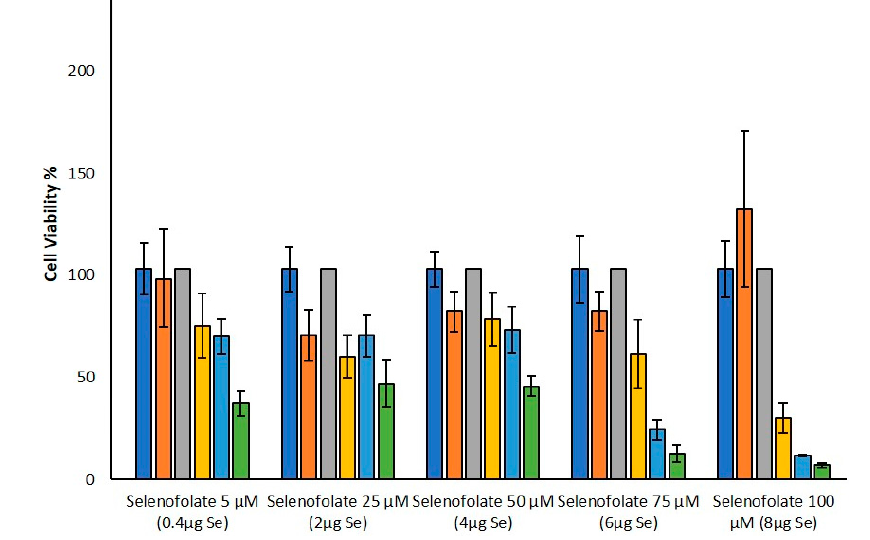
Figure 8. Analysis of metabolic activity as a function of percent cell viability during treatment of HME50-5E cells. Metabolic activity of ( a ) control and selenite, ( b ) Folic acid and ( c ) Selenofolate treated HME50-5E cells was determined by the MTT Assay. Forty-thousand cells were treated on day 5 post seeding (day 0 treatment) with 5 µ M, 25 µ M, 50 µ M, 75 µ M and 100 µ M Folic acid and Selenofolate with Se equivalents of 0.4 µ g, 2 µ g, 4 µ g, 6 µ g, and 8 µ g, respectively. The cell viabilities are shown as Means ± SE ( n = 3). Treatments were compared using two sample t test and treatments that were statistically significant at p ≤ 0.05 are summarized in Table 2. Note: HME50-5E cells were very adherent, highly metabolic and surpassed the detection capabilities of the colorimetric readings (see text and Supplementary